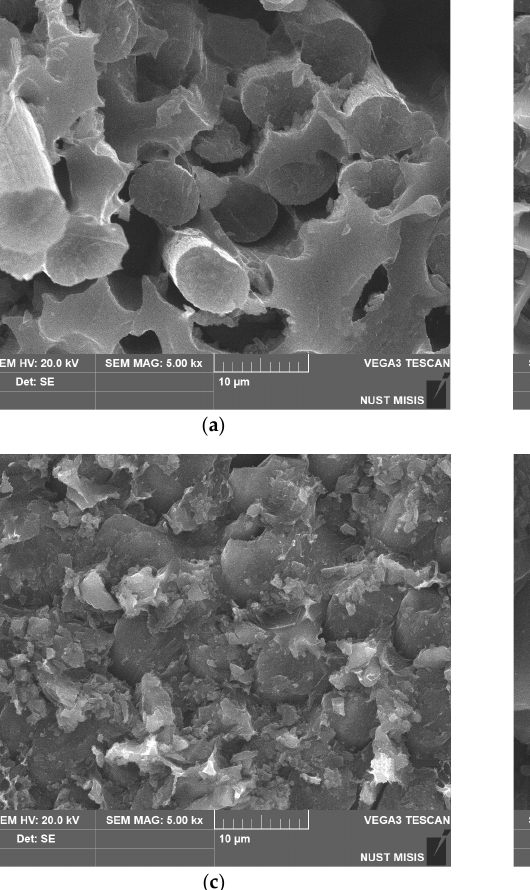
Figure 10. SEM photos of 50/50 composite materials reinforced with ( a ) initial CF, ( b ) TO 300 fibers, and ( c , d ) TO 500 fibers.